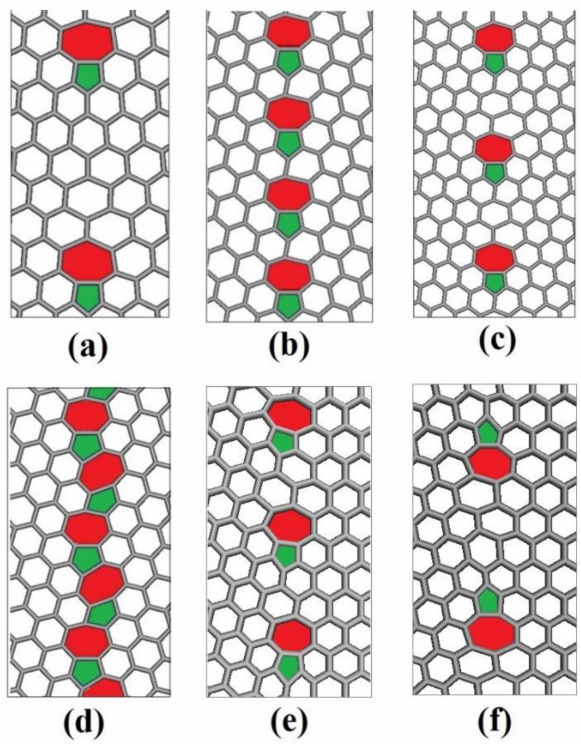
Figure 3. The applied grain boundaries between two separated h-BN and Graphene layers. ( a ) Symmetric GB’s with vectors (4, 3) | (4, 3) at armchair oriented tilt angle 9.43 ◦ and formation energy 2.83 eV/nm, containing 5 hexagonally bonded atoms between each defect pair; ( b ) Symmetric GB’s with vectors (2, 1) | (2, 1) at armchair oriented tilt angle 21.8 ◦ and formation energy 3.44 eV/nm, containing 1 hexagonally bonded atoms between each defect pair; ( c ) Symmetric GB’s with vectors (3, 2) | (3, 2) at armchair oriented tilt angle 13.2 ◦ and formation energy -i1 3.51 eV/nm, containing 3 hexagonally bonded atoms between each defect pair; ( d ) Symmetric GB’s with vectors (3, 1) | (3, 1) at armchair oriented tilt angle 32.2 ◦ and formation energy -i2 2.91 eV/nm, containing 0 hexagonally bonded atoms between each defect pair; ( e ) Non-Symmetric GB’s with vectors (3, 1) | (2, 2) at zigzag oriented tilt angles 13.89 ◦ & 30 ◦ and formation energy -i1 4.82 eV/nm, containing 2 hexagonally bonded atoms between each defect pair; ( f ) Non-Symmetric GB’s with vectors (4, 2) | (3, 3) at zigzag oriented tilt angles 19.1 ◦ & 30 ◦ and formation energy 3.23 eV/nm, containing 4 hexagonally bonded atoms between each defect